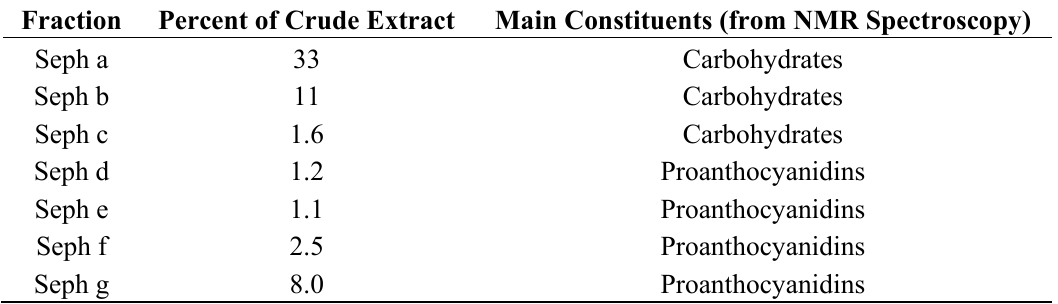
Table 1. Yield and composition of fractions from the 50% EtOH extract of aronia berries.